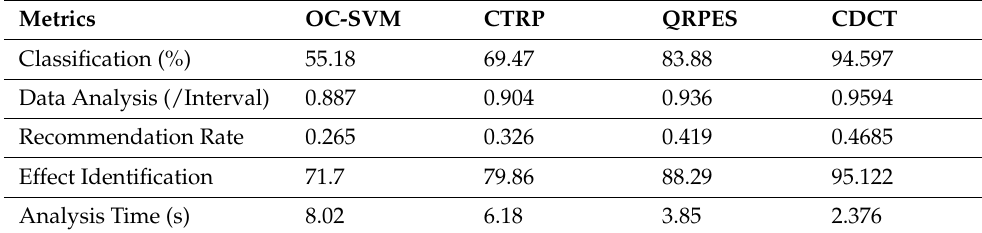
Figure 13. Data Analysis Time of Industrial Monitoring and Analysis Process. Table 3. Overall Comparative Summary (Observation